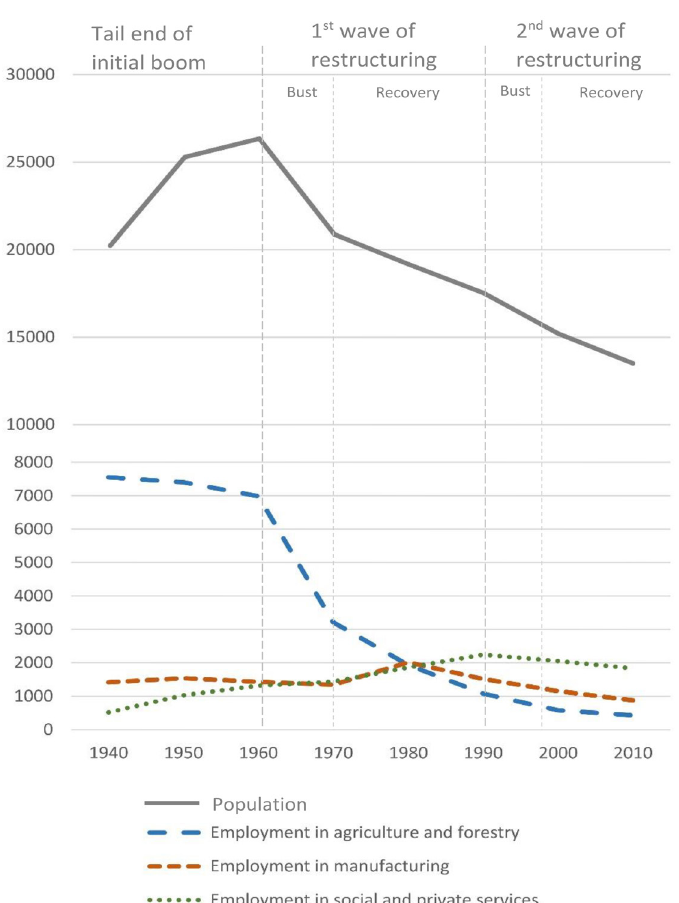
Fig. 2. The population and employment by main sectors 1940– 2010 (sources: Statistics Finland 1979,